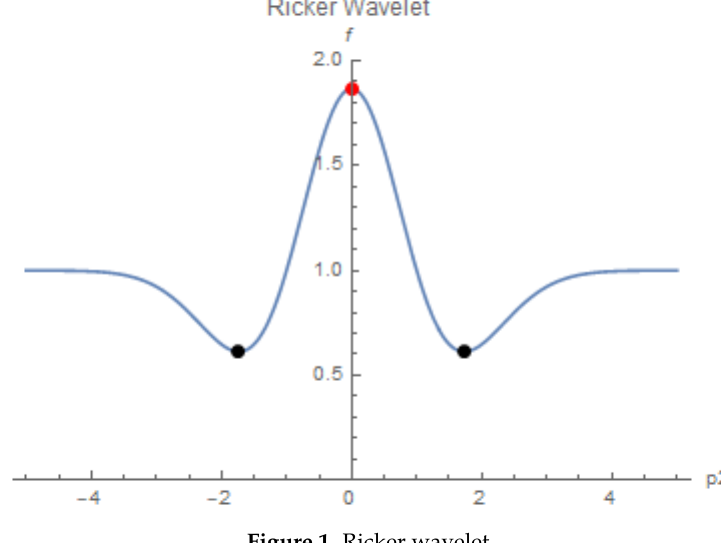
Figure 1. Ricker